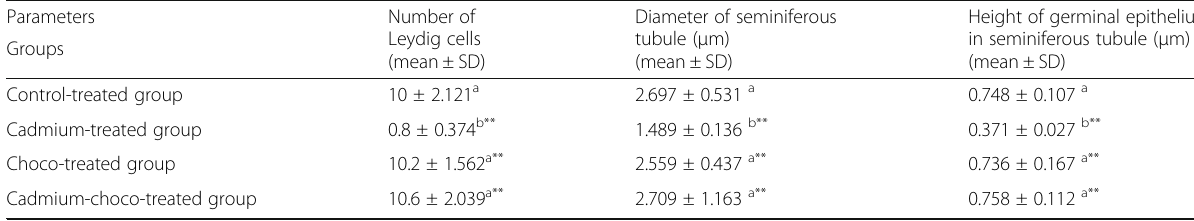
Table 3 Testicular morphometric analyses in male Swiss albino mice exposed to sublethal concentration of cadmium individually and in mixture with chocolate fortified with zinc nanoparticles